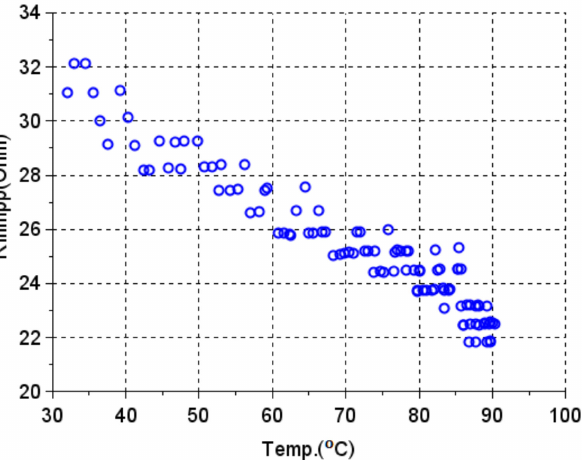
Figure A3. Change in the panel’s maximum power point resistance caused by temperature (measured for a 10 W panel).